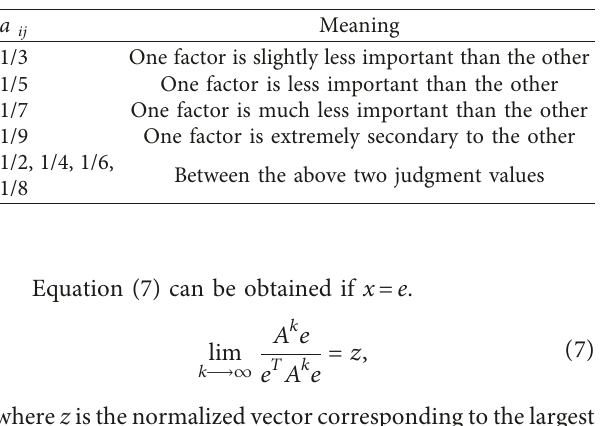
Table 2: Secondary degree